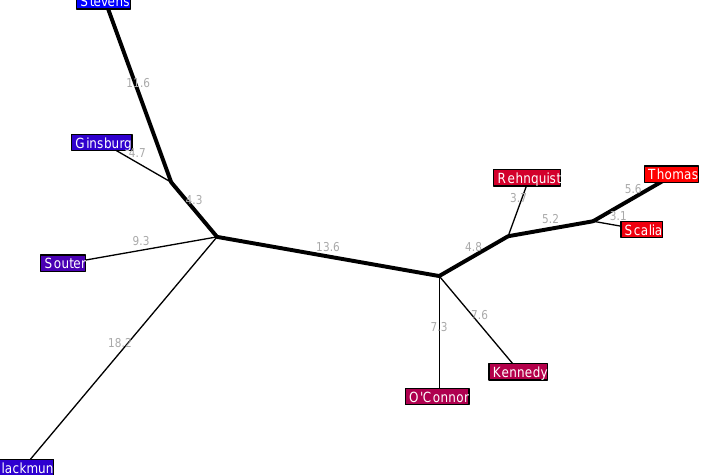
Figure 7. Judicial tree for the 1993–1994 Rehnquist 6 Court. The 1975–1981 Burger 6 Court in Figure 8 is quite remarkable: the Court has essentially fractured into a tripolar configuration. Marshall and Brennan are closely united on the liberal side, and joining them from a considerable distance at a center-left political position is Stevens—who not only is a sizable distance of 11.9% to the right of them, but he also extends a sizable 10.5% from the major axis, indicating disagreements with the liberals that occur in both the standard political direction and an additional unspecified direction. On the right we have a fairly standard configuration of three conservative justices, but quite unusually in the center of the Court we have a trio of justices—White, Blackmun, and Stewart—who all join the major axis at the same exact location yet the approximate disagreement rates between them are rather large, ranging from 24.7% to 25.6%. I think it would be fascinating to look further into the ideology and judicial behavior of these three centrist justices to see what sets them apart from the rest of the Court and from each other, but a deep dive into the cases they have voted on is beyond my